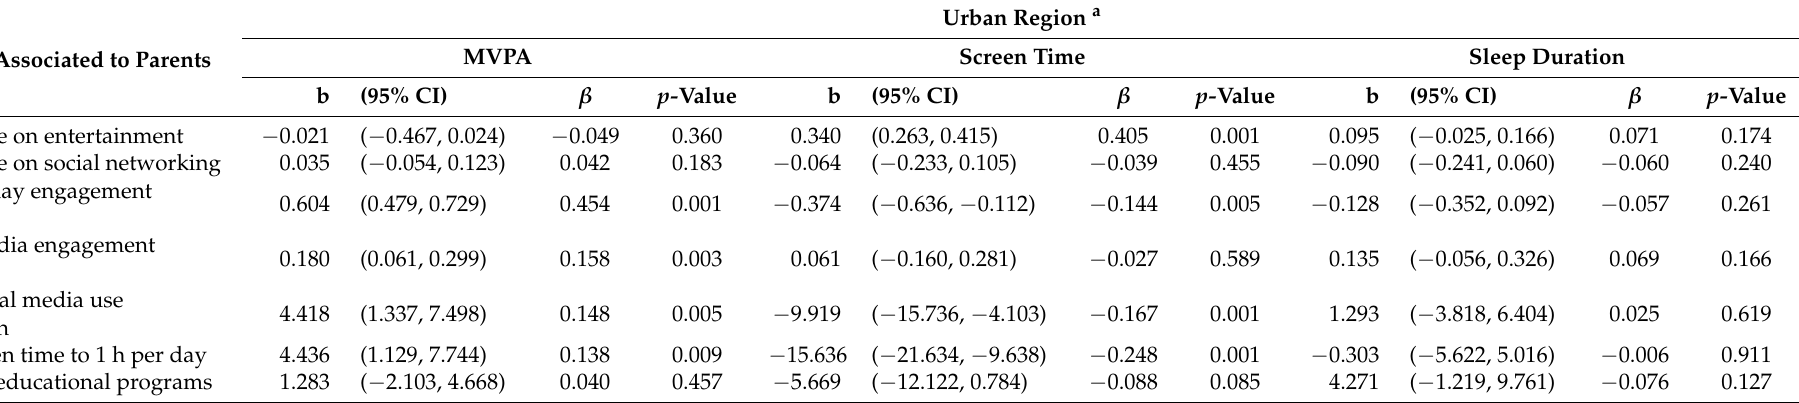
Table 4. Results from multiple regression analyses of 24-h movement guidelines and parents’ digital media habits, engagement, awareness for urban children.